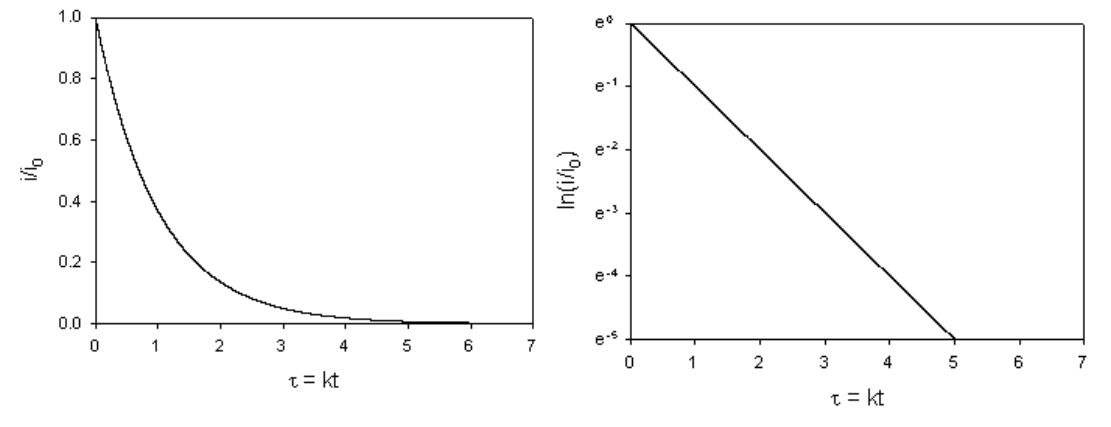
Figure 1. Plot of normalized current versus normalized time corresponding to the chronoamperometric response profile of a redox active monolayer. The linear semilogarithmic plot is characteristic of this